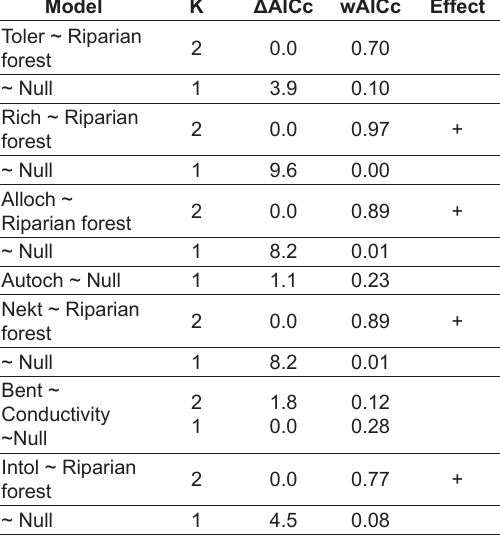
Table 3. Best models to explain the occurrence of different ecological groups (Toler – hypoxia-tolerant; Intol – hypoxia-intolerant; Nekt – nektonic; Bent – benthic; Autoch – autochthonous-feeders; Alloch – allochthonous-feeders) and species richness of fish (Rich) in 13 headwaters distributed among four rivers, Cabeça, Corumbataí, Passa Cinco e Ribeirão Claro, in the Rio Corumbataí River Basin, São Paulo State, southeastern Brazil. K – numbers of estimated parameters for each model; ΔAICc – Akaike corrected for small samples; wAICc – Akaike’s weight of evidence. Null model represents the absence of